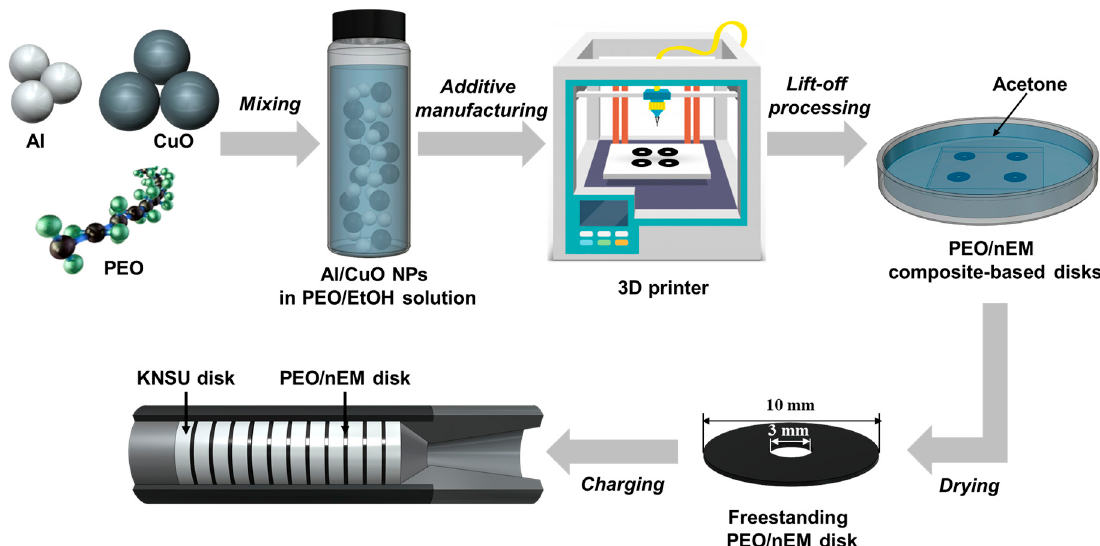
Figure 1. Schematic of the fabrication of PEO/nEM composite-based 3D disks and their charging into the combustion chamber of a small rocket motor.